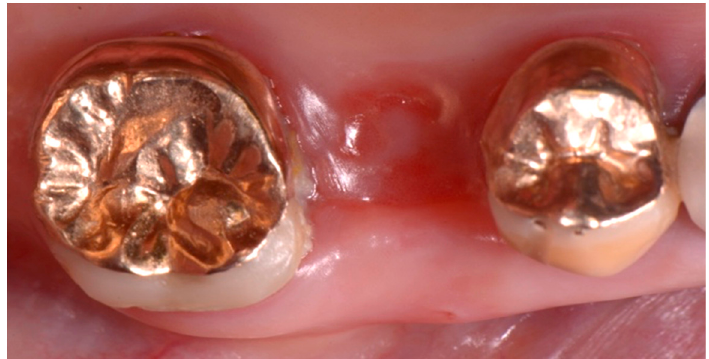
Figure 8. Intra-oral clinical view after 2 weeks from the intervention, showing that complete re-epithelization was visible at the surgical post-extraction